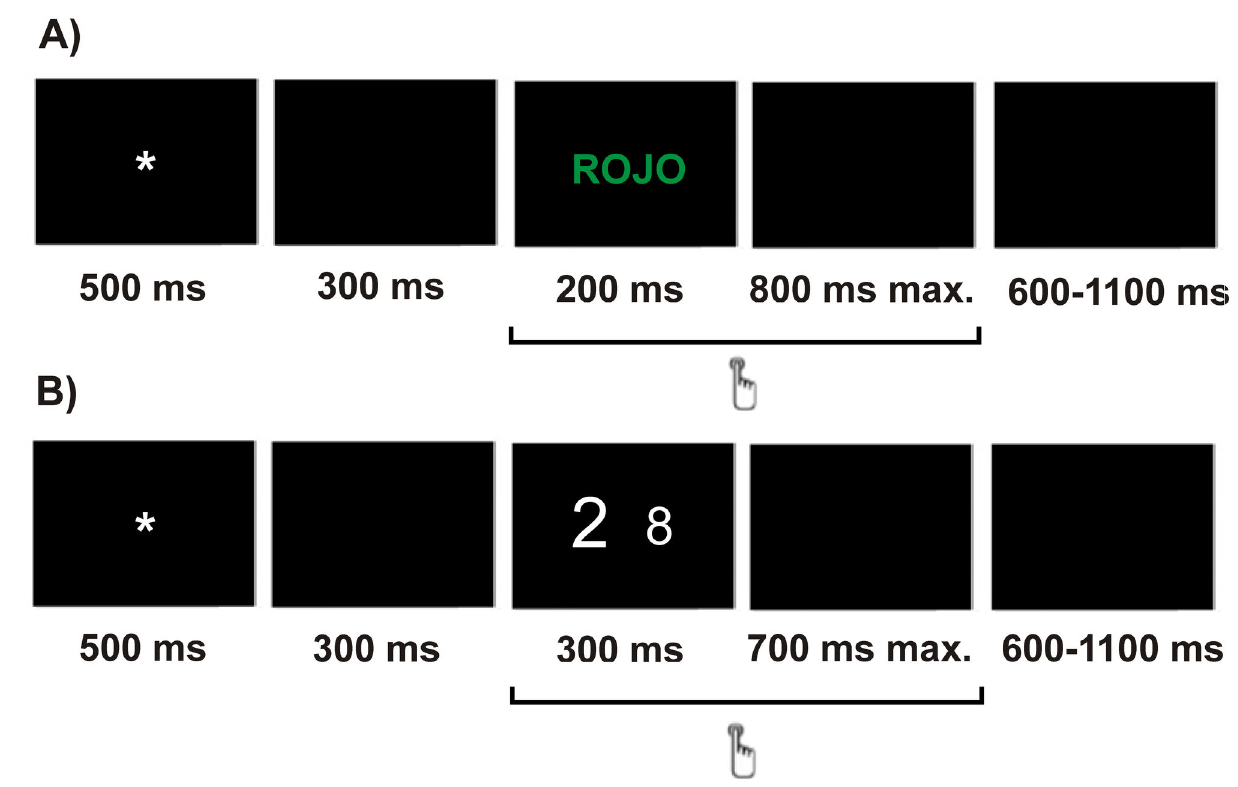
Figure 1. One trial structure of an incongruent stimulus of the classical (A) and numerical (B) Stroop tasks and its